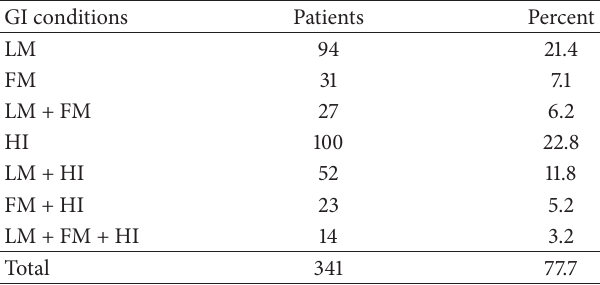
Table 2: Prevalence rates of LM, FM, and